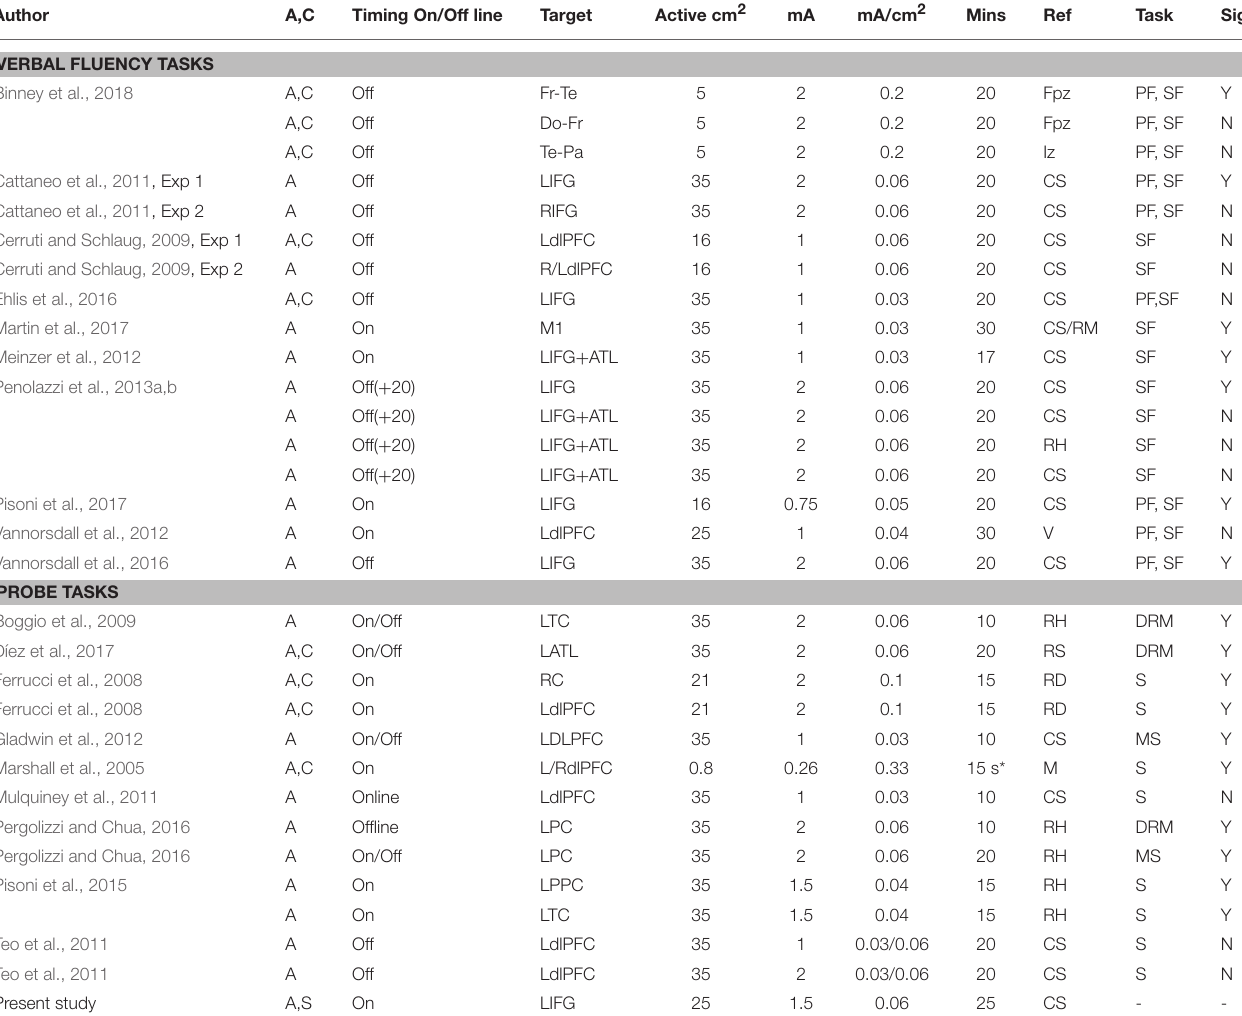
TABLE 1 | Table summarizing protocols used by previous studies measuring effects on verbal fluency and probe tasks including protocol used in present study at the bottom in